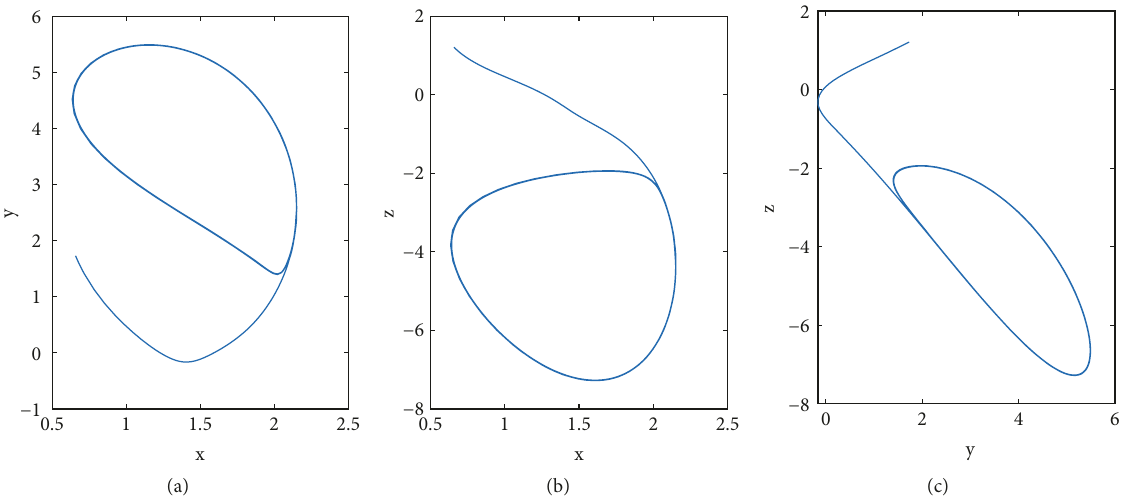
Figure 7: Two-dimensional phase diagram of system (1) with identified parameters: (a) 2D ( 𝑥 − 𝑦 ), (b) 2D( 𝑥 − 𝑧 ), (c) 2D ( 𝑦 − 𝑧 ).